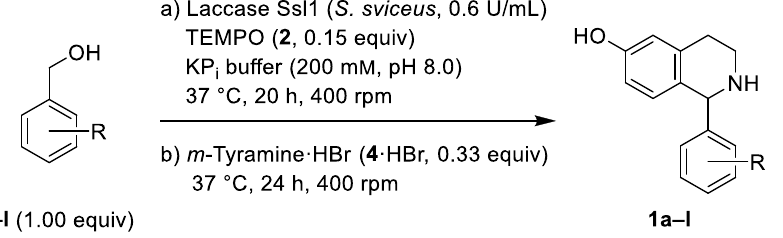
Scheme 7. Chemoenzymatic one-pot process with benzylic alcohols 3a – l and m -tyramine hydrobro- mide ( 4 · HBr) towards 1-phenyl-1,2,3,4-THIQs 1a – l ; for results see Table 4. Table 4. Yields of sequential one-pot